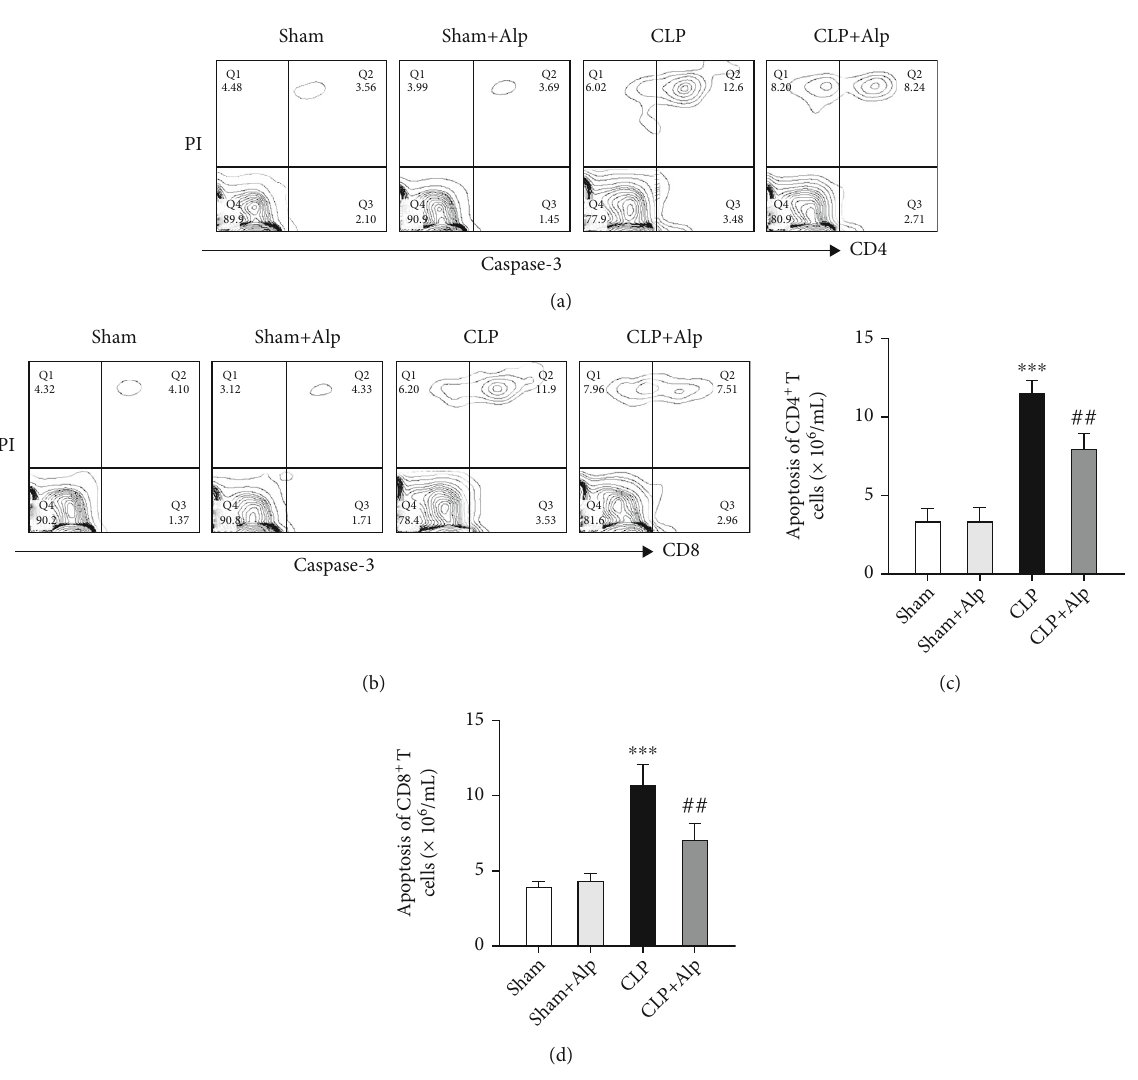
Figure 5: E ff ects of alpinetin on apoptosis of CD4 + and CD8 + T cells in the spleen. Flow cytometry was then used to evaluate the apoptosis by detecting caspase-3 activation and cell death (PI positive) of CD4 + (a, c) and CD8 + (b, d) T cells in the spleen on the eighth day. Sham ( n = 8 ), sham+Alp ( n = 8 ), CLP ( n = 6 ), and CLP+Alp ( n = 8 ). Data are shown as mean ± SD . ∗∗∗ p < 0 : 001 , CLP vs. sham; ## p < 0 : 01 , CLP-Alp vs.